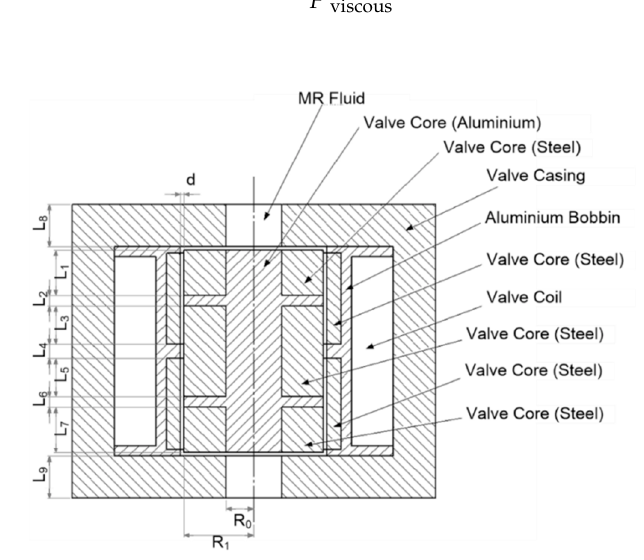
Figure 5. Valve structure with components and geometrical notation.